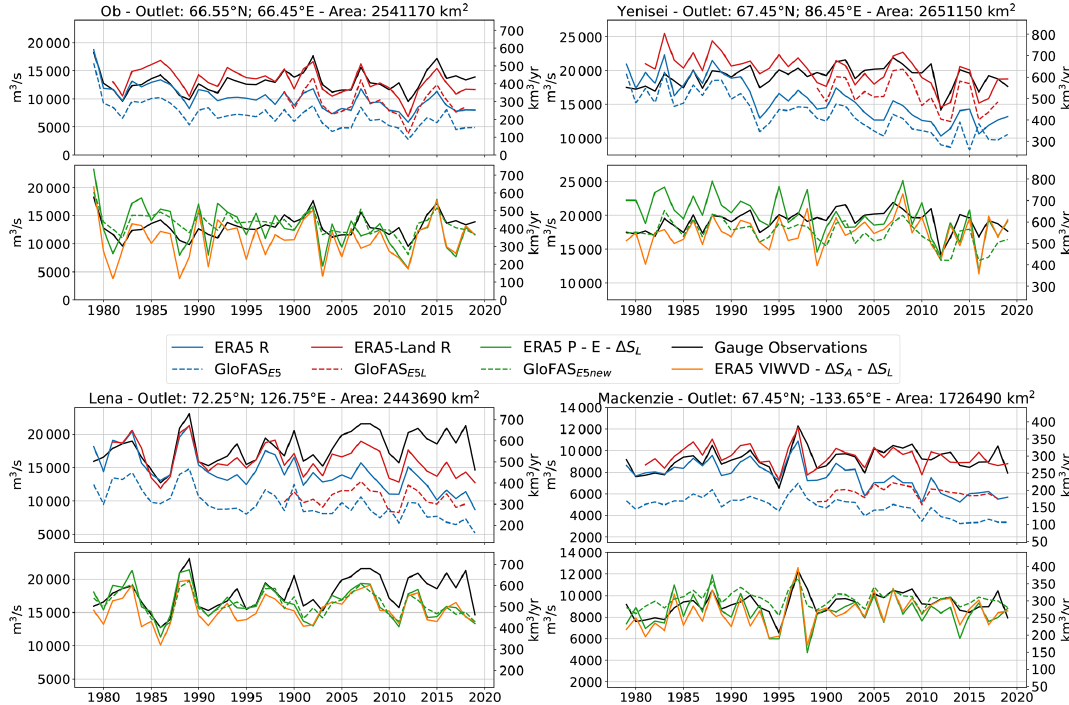
Figure 3. Annual means of observed river discharge, ERA5 runoff, ERA5 net precipitation, ERA5 VIWVD, and ERA5-Land runoff as well as GLOFAS E5 , GLOFAS E5L , and GLOFAS E5 for the period of 1979–2019 (1981–2019 for ERA5-Land and 1999–2018 for GLOFAS E5L ). new Table 5. Mean values and standard deviations of river discharge as well as relative decadal trends and their standard errors (see Eq. 10), calculated over the period 1981–2019 (1999–2018 for GloFAS E5L , indicated by the superscript ∗ ). Units are the same as in Table 4. Trends that are not significant are marked with a superscript n . Additionally, normalized RMSE values and correlation coefficients for annual means, calculated in relation to observations (Table 4), are given. Bold values identify the best correlation coefficients and NRMSE